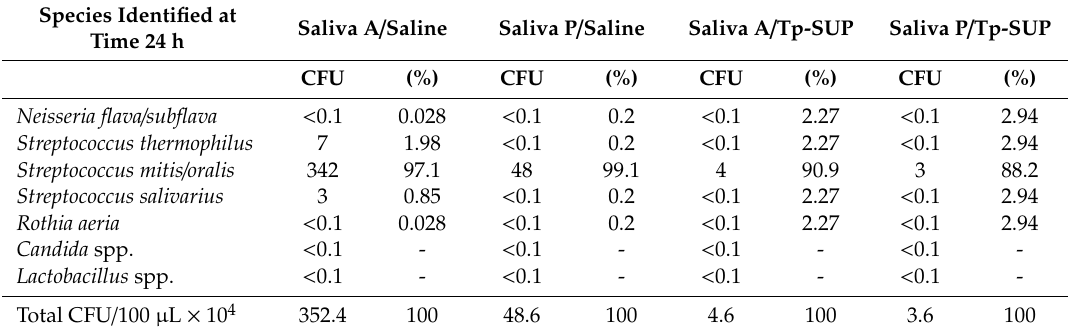
Table 2. Microbial load onto saliva-contaminated OE subsequently exposed or not to